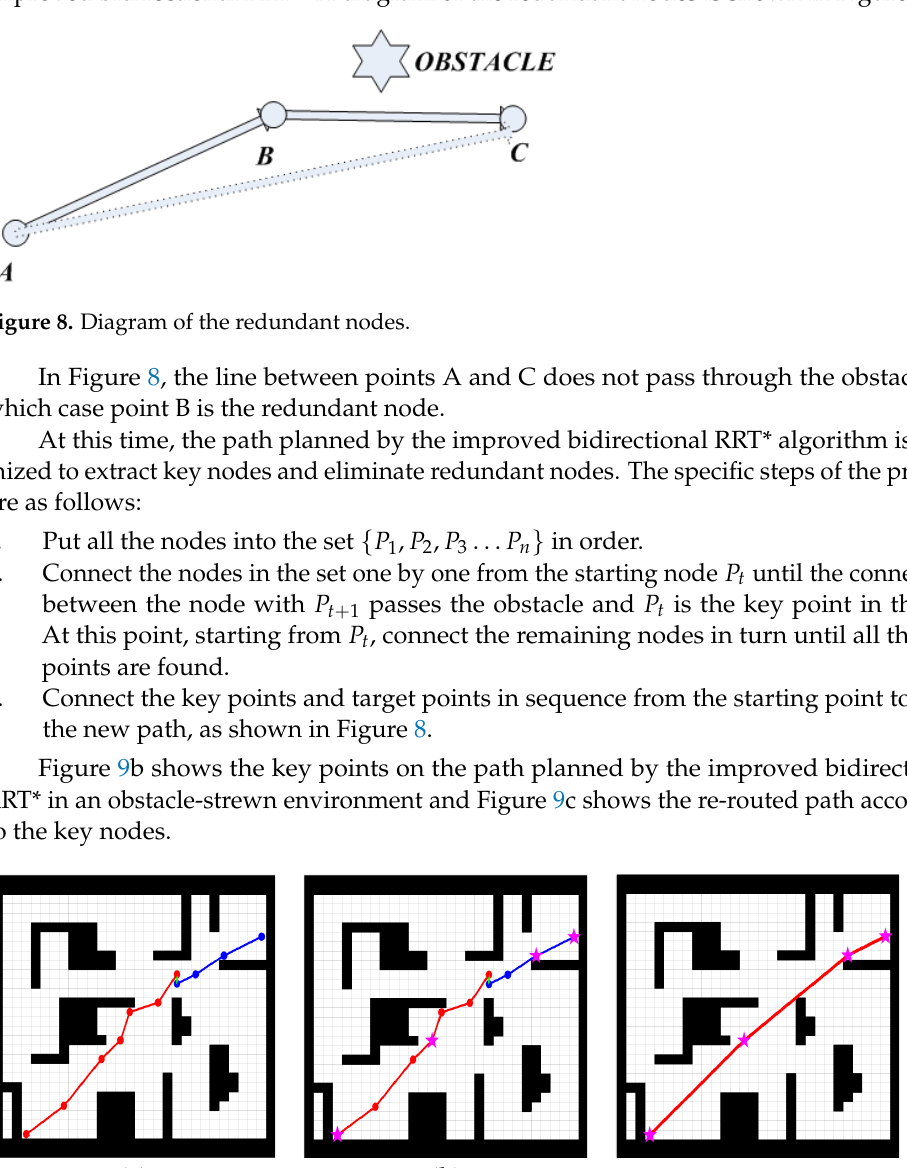
Figure 8. Diagram of the redundant nodes.